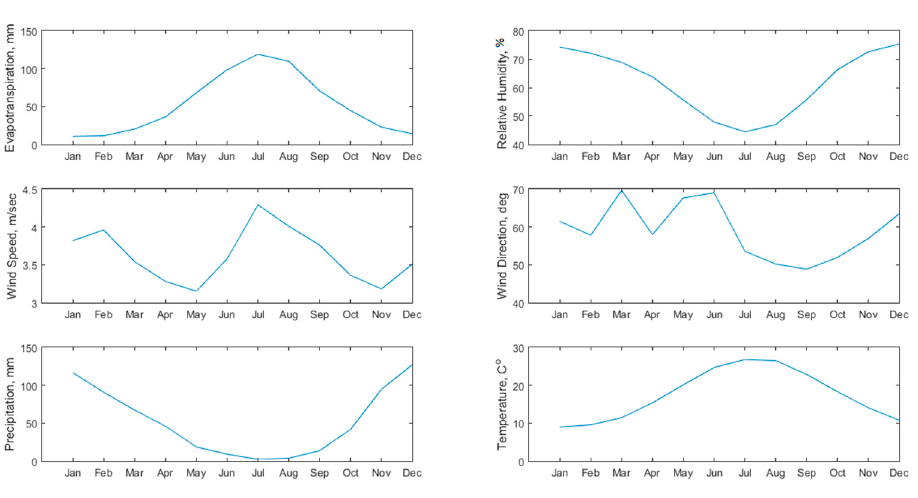
Figure 3. The monthly variation in Agia Paraskevi station meteorological variables: potential evapotranspiration, relative humidity, wind speed, wind direction, precipitation and temperature.